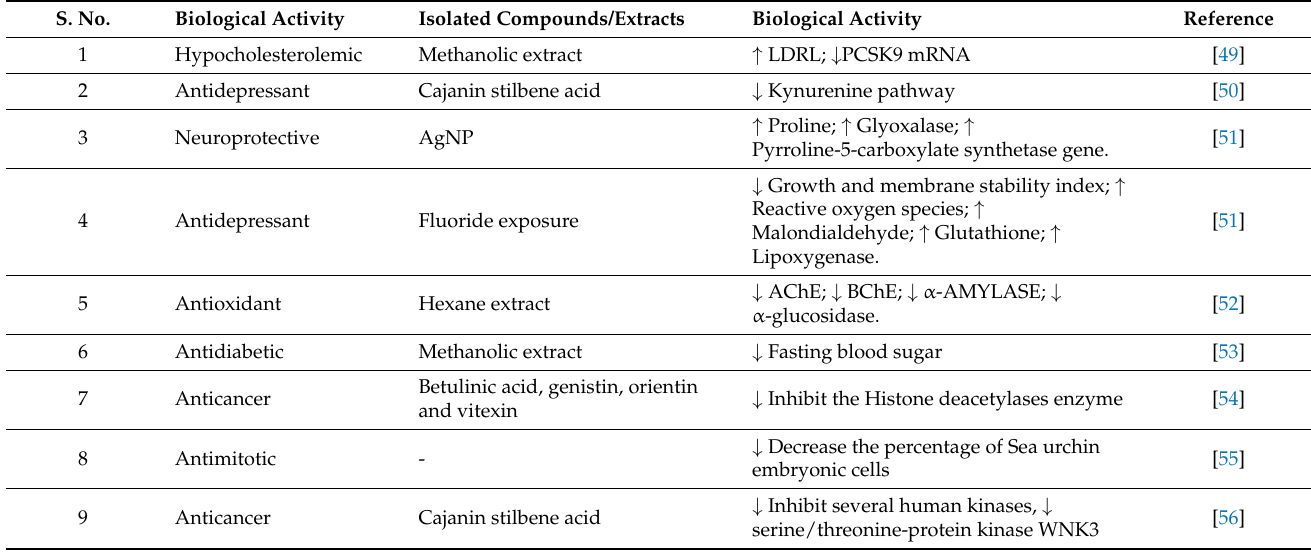
Table 8. Molecular regulatory mechanism of few biological activities of Cajanus cajan